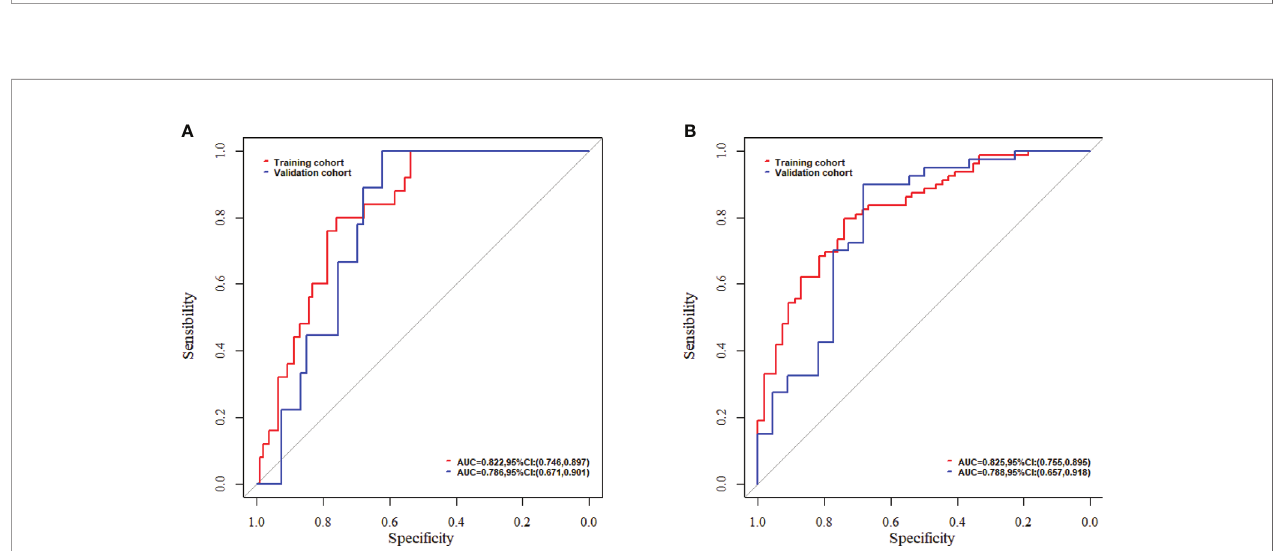
FIGURE 5 | (A) Radiomics nomogram integrated with radiomics signature and clinical factor; calibration curves of the radiomics nomogram for (B) 3 months survival and (C) 1 year survival.